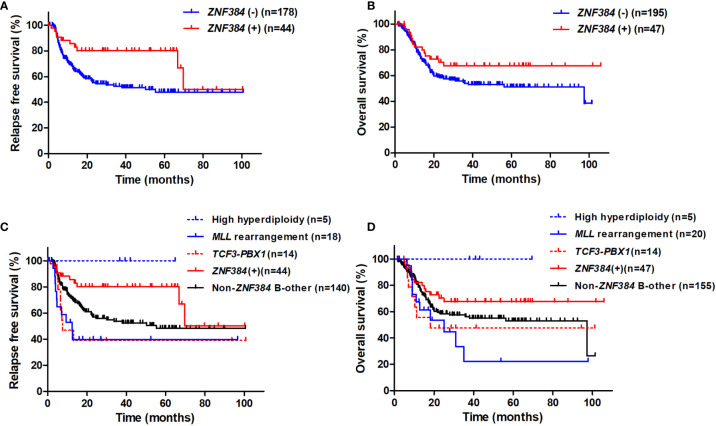
The impact of ZNF384 fusions on RFS and OS in the whole cohort. (A) RFS, grouped by ZNF384 fusions. (B) OS, grouped by ZNF384 fusions. (C) RFS among subtypes. (D) OS among subtypes.